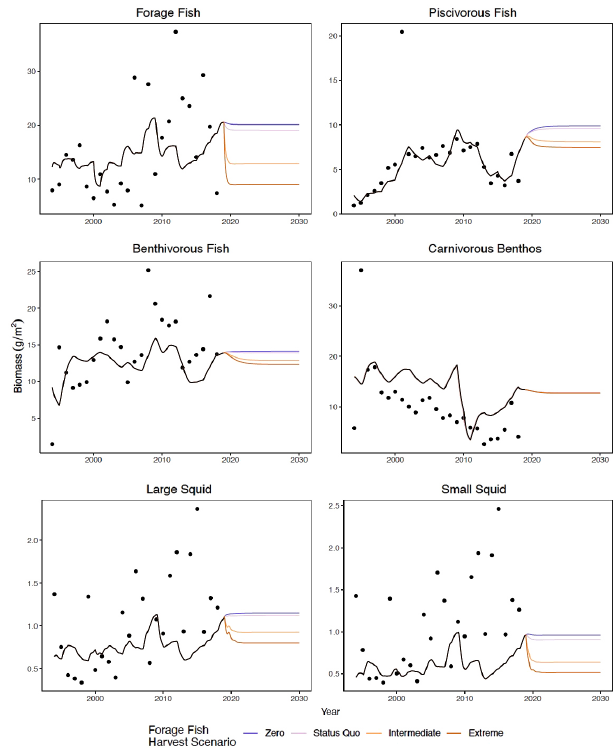
Fig. 4 . The Ecopath with Ecosim food web model biomass trajectories under four different scenarios of commercial forage fish harvest. Note that scenario forecasts for carnivorous benthos were similar, with forecasts overlaying each